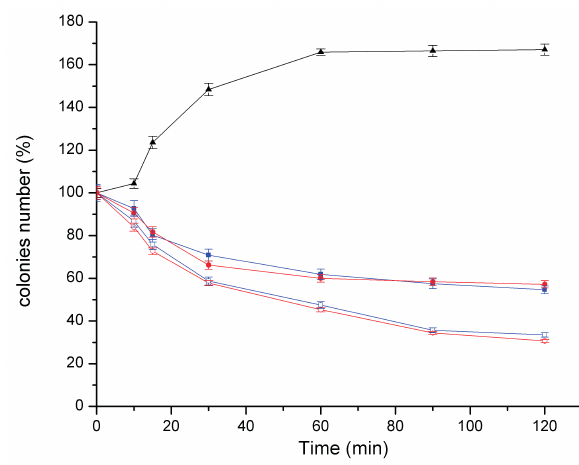
Figure 9: Evolution as a function of time of number of S typhi colonies survived in culture media in the presence of PIP (-●-), NAD (-■-), ZnAl- CO (– ▲ –), ZnAl- CO -NAD (–□–), ZnAl- CO 3 3 3